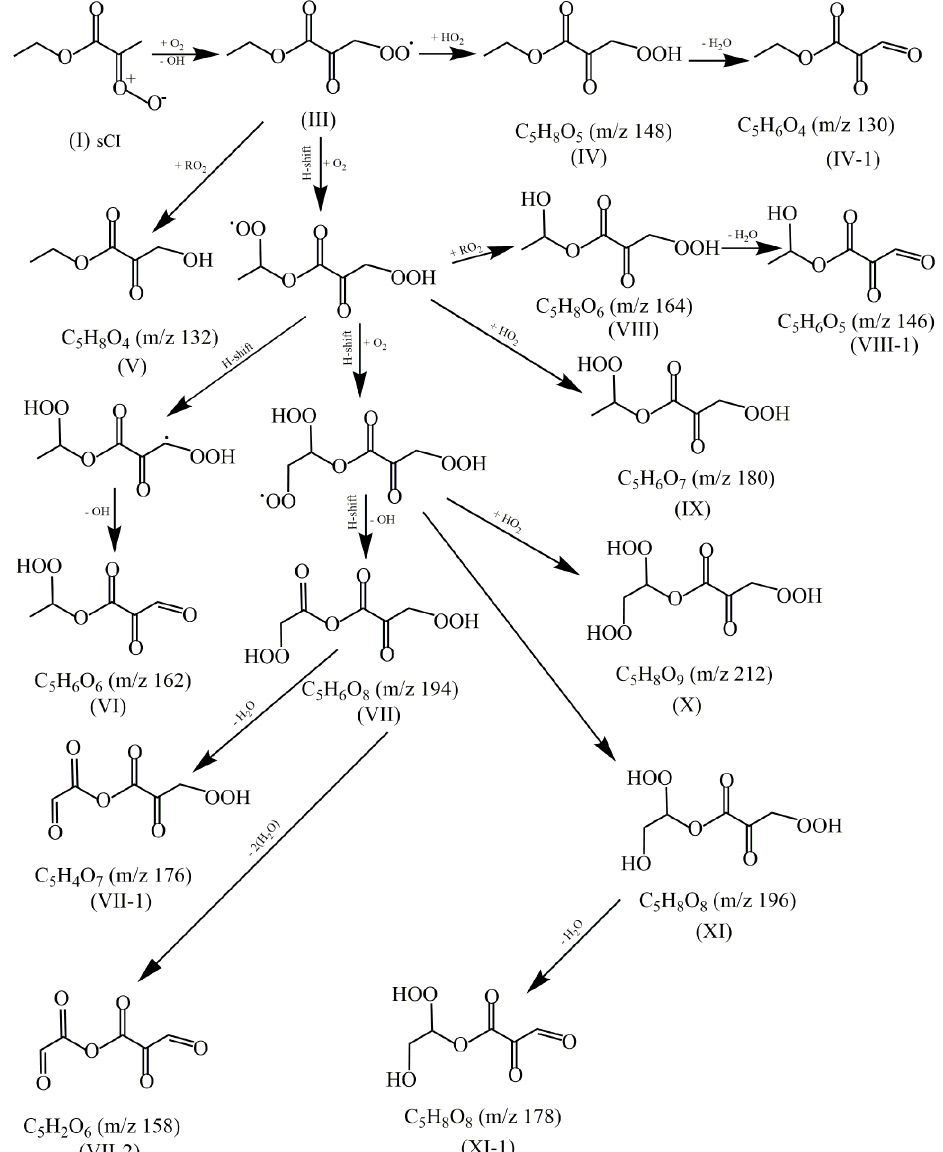
Scheme 1. Proposed mechanism for EM ozonolysis in the presence of AS